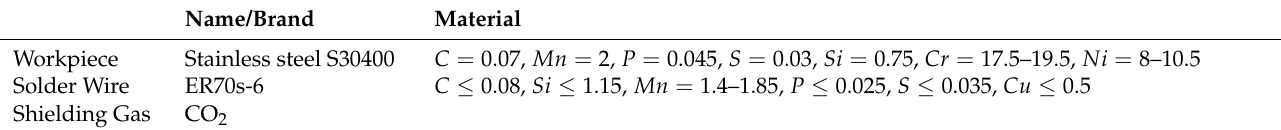
Table 1. Characteristics of materials of physical